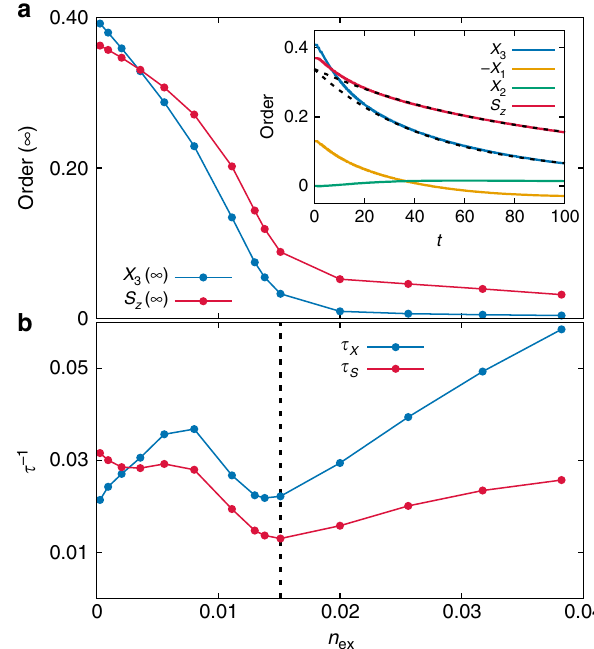
Fig. 2 The photo-induced reduction of spin-orbital-ordering. a The extrapolated order parameters X 3 ( ∞ ) and S z ( ∞ ). Inset: Time evolution of spin and orbital-order parameters after the electric fi eld pulse with n ex = 0.015. Dashed lines show an exponential fi t. b The fi tted relaxation rate τ (cid:1) 1 S and τ (cid:1) 1 X for the spin ( S z ) and orbital ( X 3 ) order parameters, respectively. As the excitation density n ex increases, the spin relaxation rate drops below the rate for the orbital order. Both spin and orbital relaxations slow down close to n ex ~ 0.015 (labelled by the vertical dashed